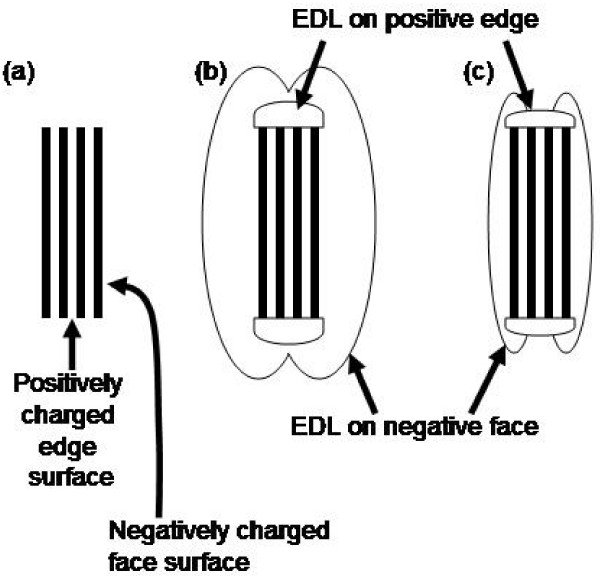
Schematic representation of the electrical double layers (EDL) around a clay particle under low and high ionic strength conditions. The pH < pHpzc is assumed. (a) A model clay particle (domain). (b) Clay particle suspended in a low ionic strength solution. The EDL is comparable to the particle thickness, and as a result, EDL on edge surfaces are masked by EDL on face surfaces. (c) Clay particle suspended in a high ionic strength solution. EDL is relatively thin, and EDL on edge surfaces are exposed. As a result, there is electrostatic attraction between oppositely charged face and edge surfaces. After Tombacz and Szekeres (2006).